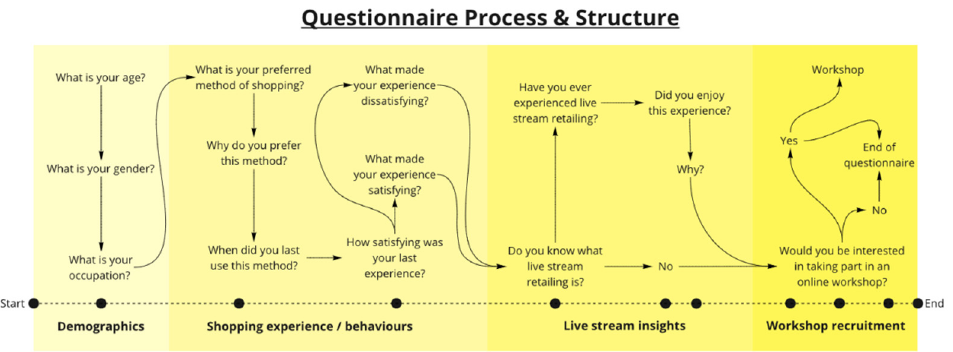
Figure 4. Research questionnaire outline, illustrating different stages, and potential insights/findings from questions—created in